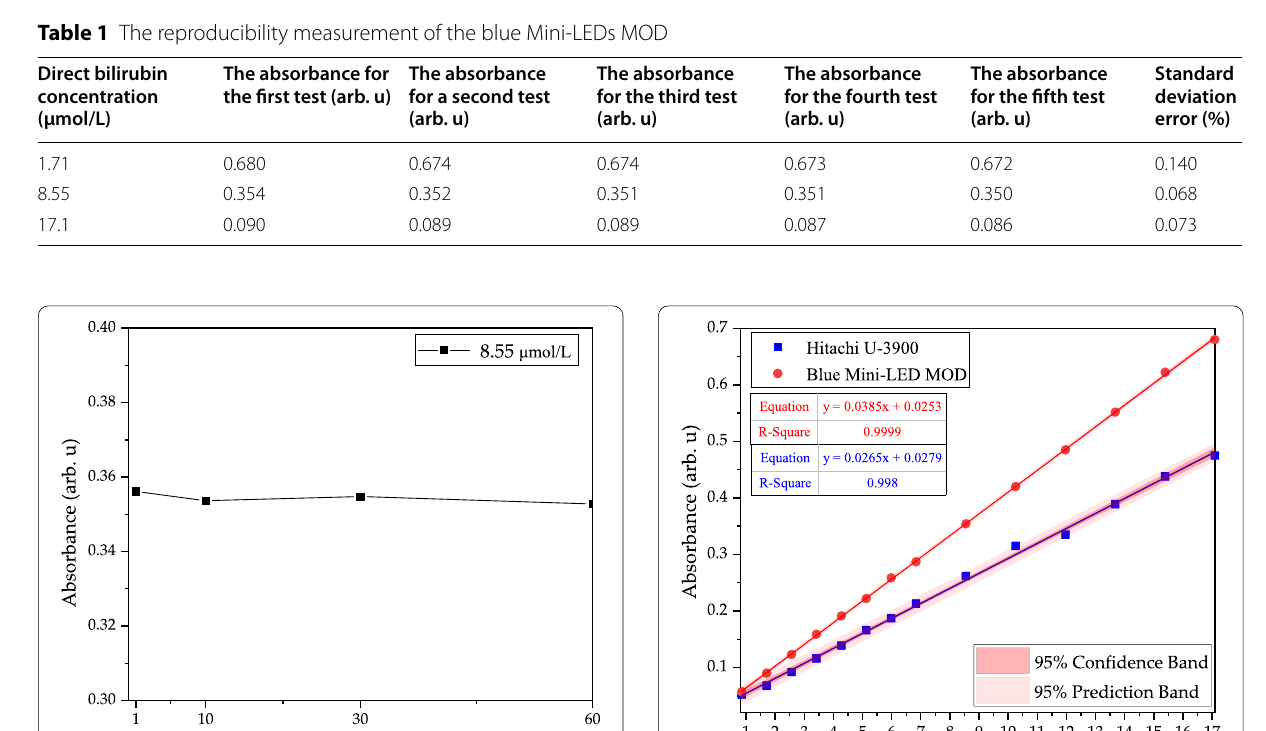
Fig. 10 The absorbance for the direct bilirubin after driving the LEDs for 1, 10, 30, and 60 min